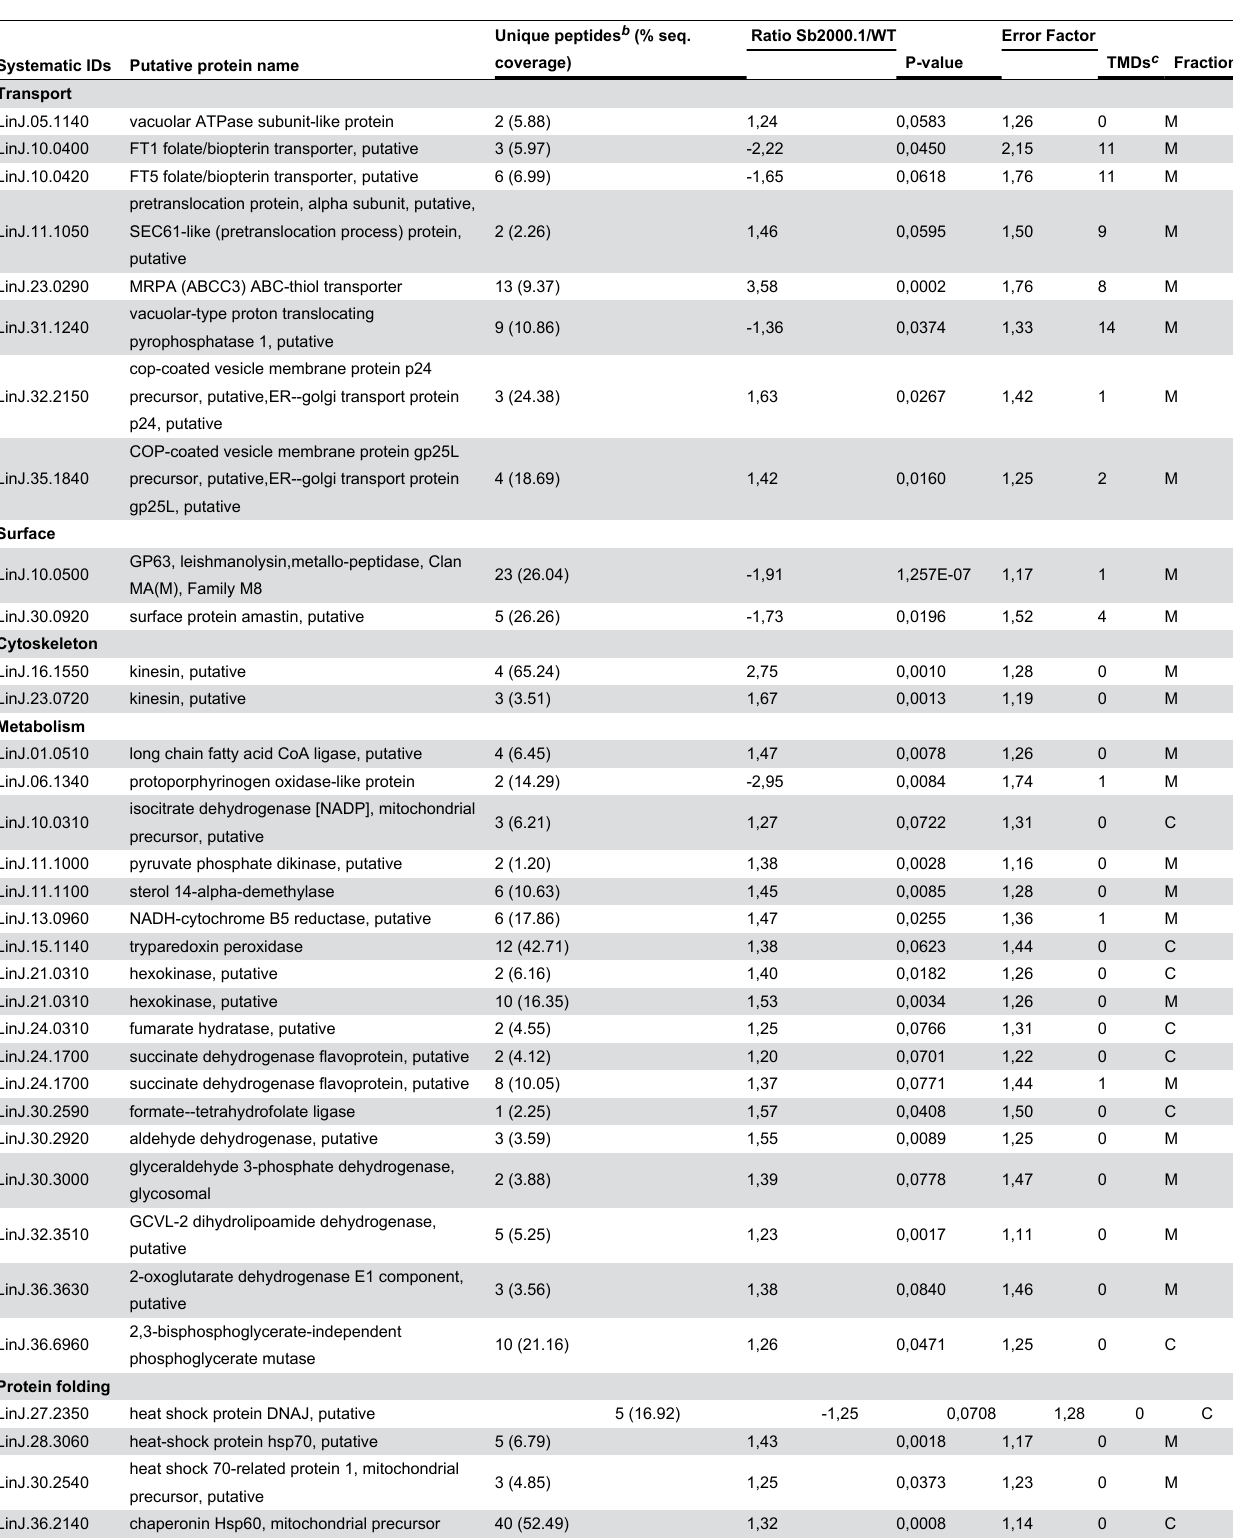
Table 1. MS/MS identifications of differentially expressed proteins in Sb2000.1 compared to WT in SILAC experiments a